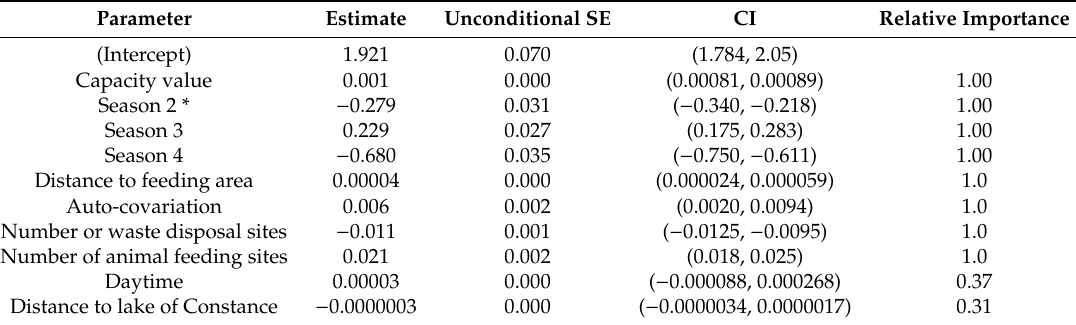
Table 2. Summary results of crow abundance after model averaging: e ff ects of each parameter on crow abundance.